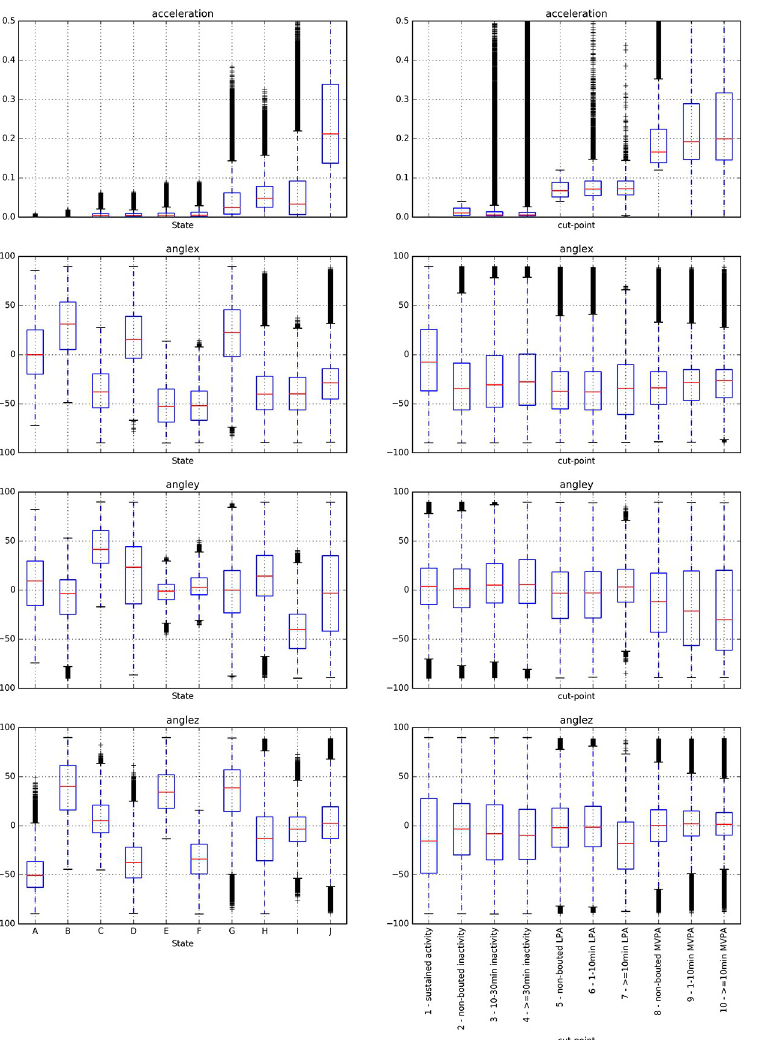
Fig 4. Boxplots for acceleration and angle values per HSMM state (acceleration+angles model, left column) and cut-points category (right column).